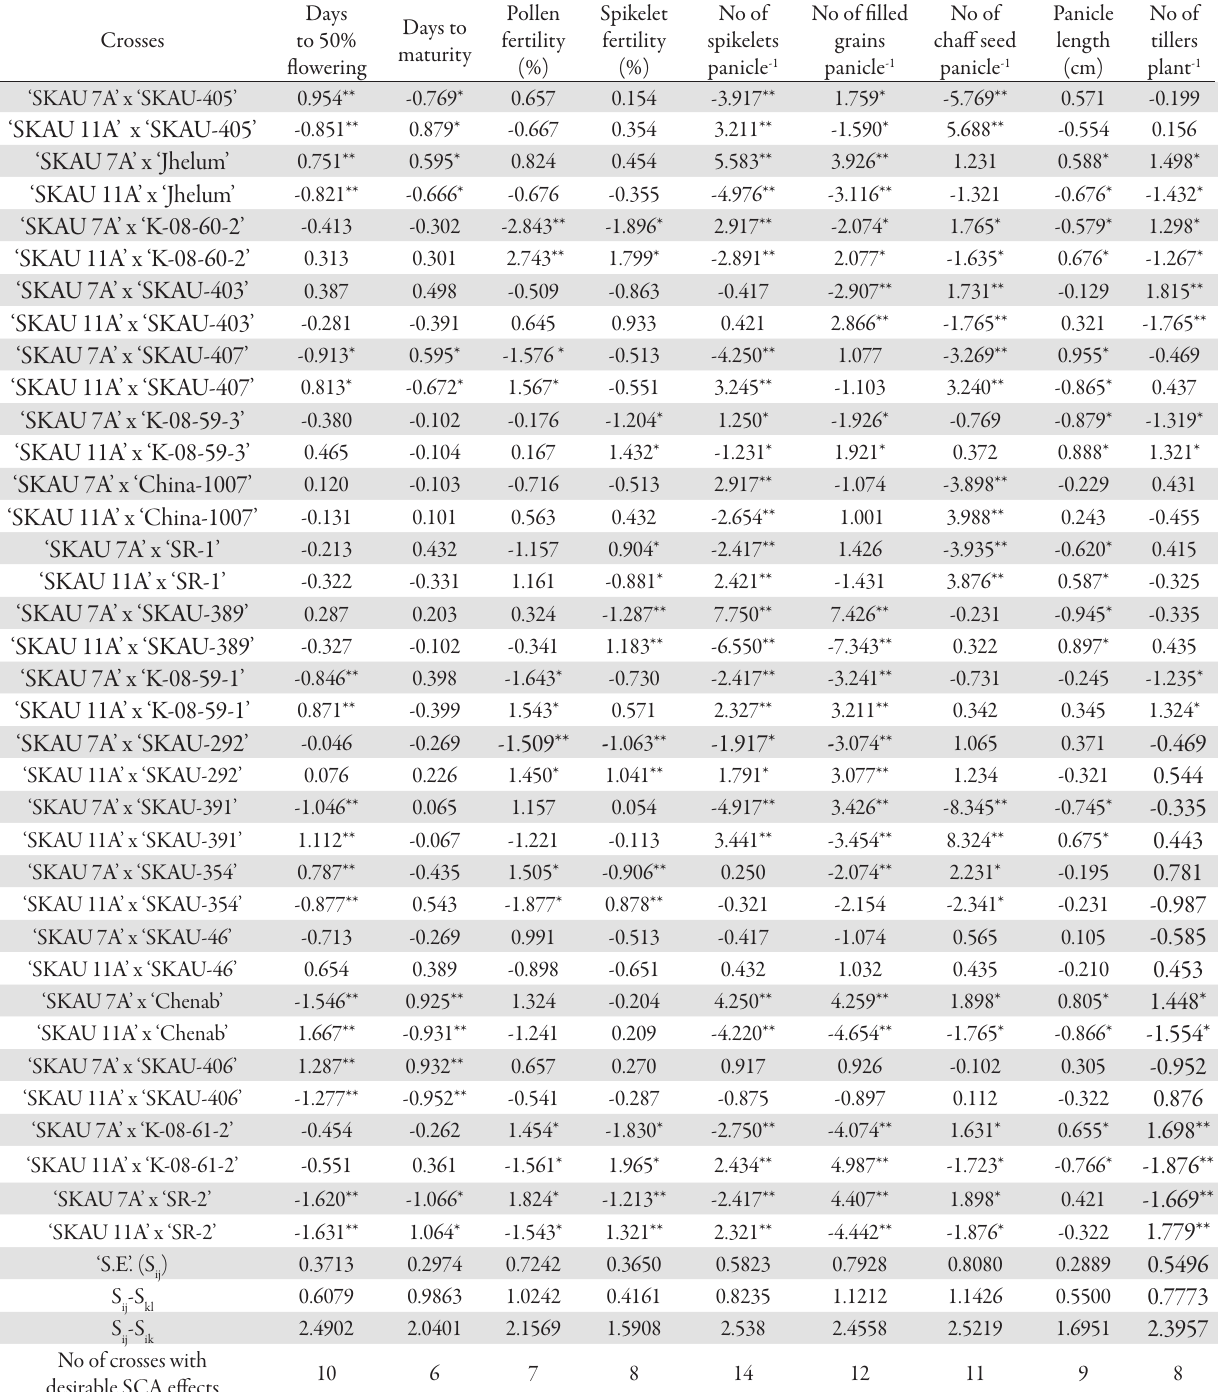
Tab. 6. Specific Combining Ability (SCA) effects of lines and testers for various agro-morphological traits in rice Crosses